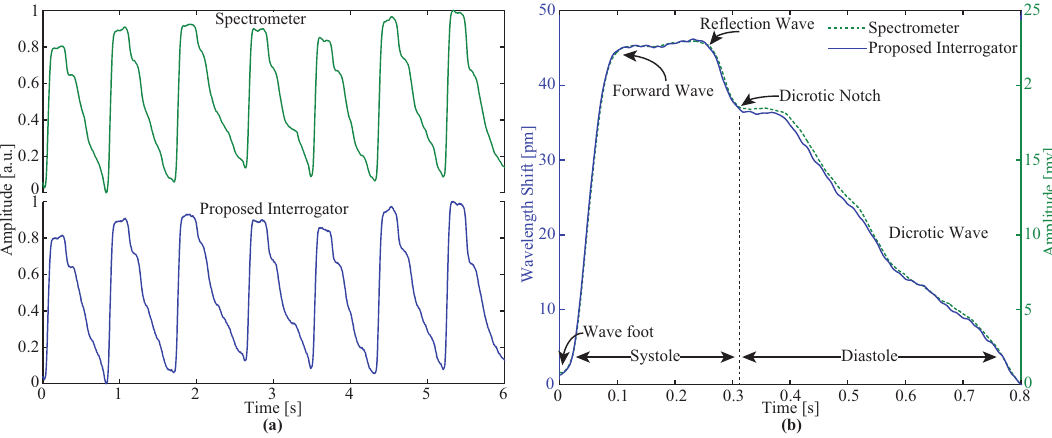
Figure 5. Signals acquired by the spectrometer and the proposed interrogator: ( a ) Sequence of seven pulses; ( b ) Comparison of a single